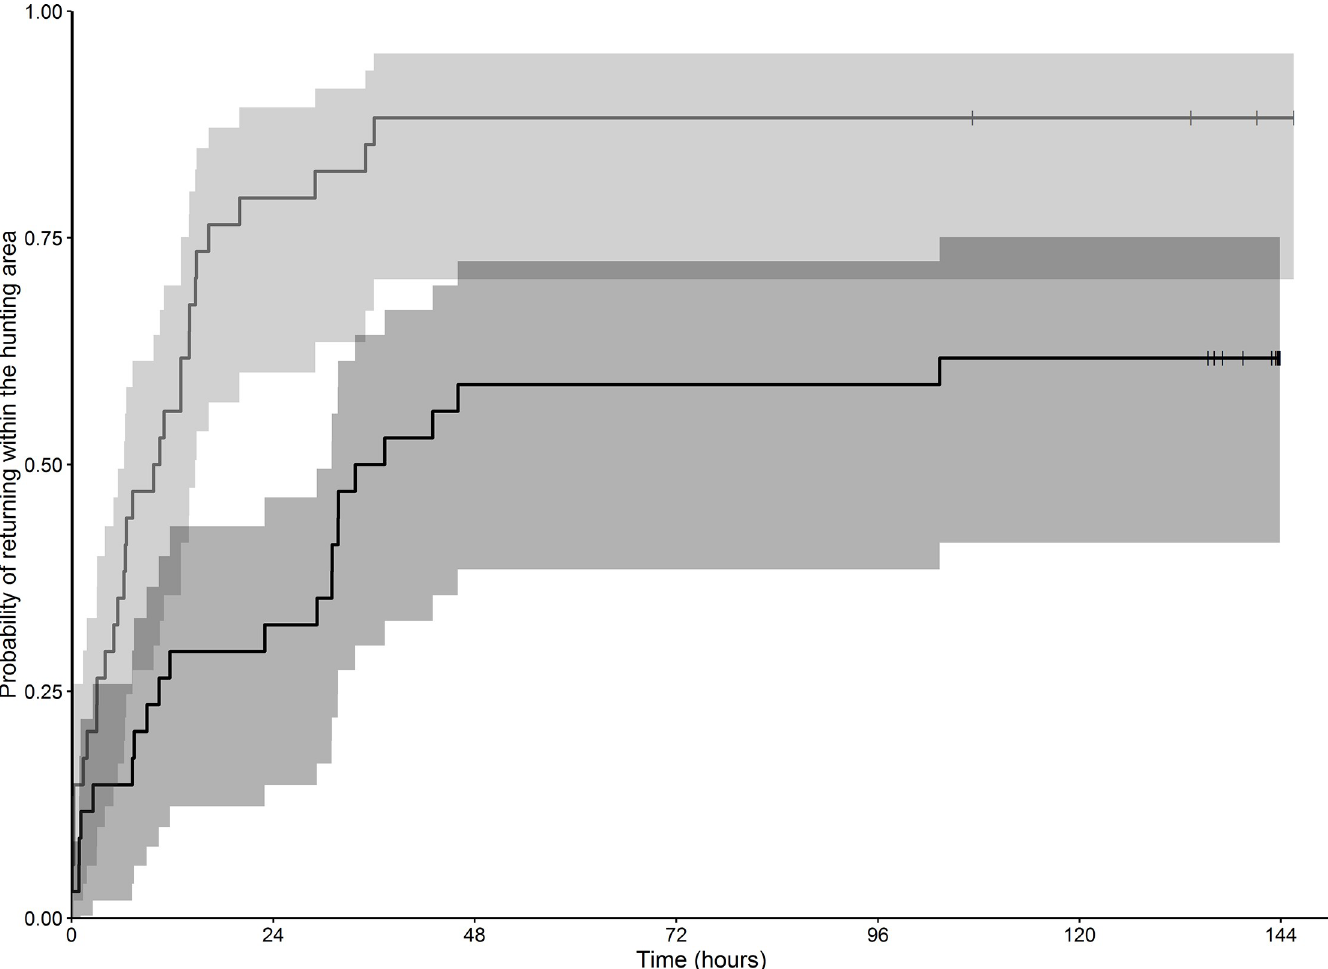
Fig 5. Kaplan-Meier estimates of the probability of returning to the hunted area before (in light grey) and after hunting (in dark grey) as a function of time. Grey parts on both sides of the lines correspond to 95% confidence intervals. Small vertical bars crossing the curves indicate censored values ( i . e . no return to the area, even one week after the drive